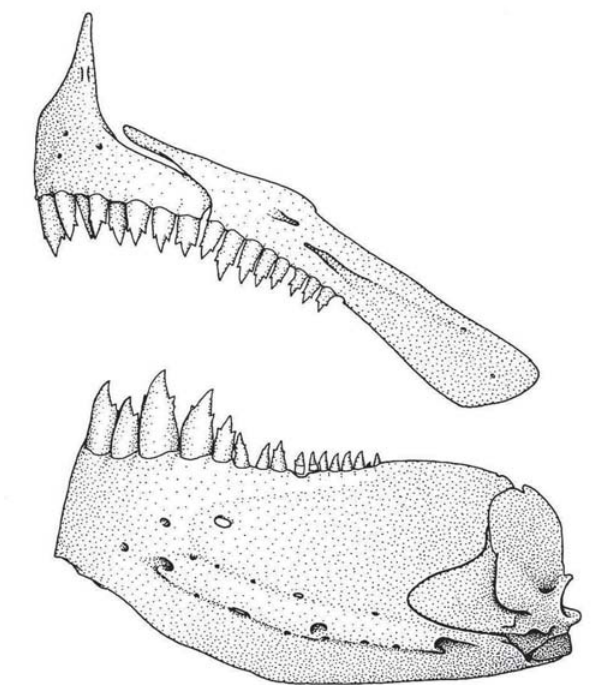
Fig. 76. Mimagoniates rheocharis , adult male, USNM 279879, paratype, 45.4 mm SL; jaws and dentition of adult male, lateral view, right side, anterior at left. Modified from Menezes & Weitzman